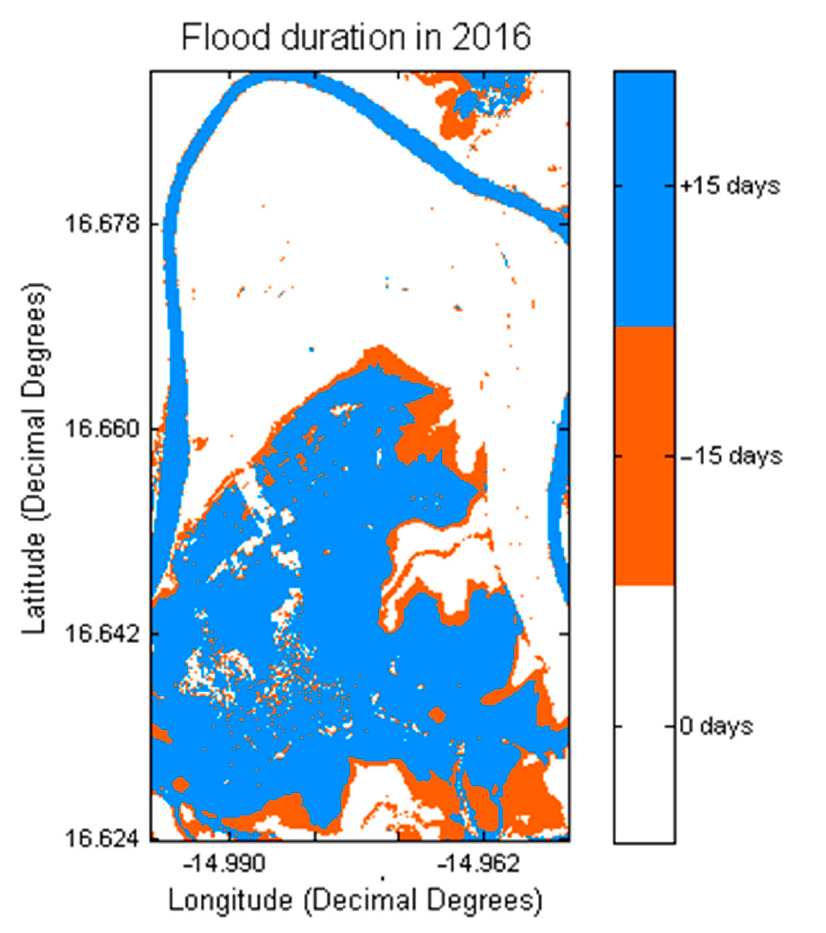
Figure 10. Surface areas flooded for less (and more) than 15 days in the Podor basin in 2016. Figure 11 shows the annual evolution of the flooded area S (ha) and that of the river level h (cm) and a similar evolution can be seen between the two curves. The lack of images at certain periods or the existence of clouds did not allow a higher accuracy on the maximum surface reached. In order to take into account the portions of the watercourse present in the image, an estimated constant value of 150 ha was subtracted from the calculated area to obtain the flooded area The duration of submersion depends on the spread of the flood (duration of the maintenance of the high river level). For a given surface, the minimum duration of submersion can be estimated by joining horizontally the rising and falling parts of the flooded surface curve. Looking for a relationship between the river level and the flooded area, the best correlation (R 2 = 0.92) was obtained between the river level at day 1 and the flooded surface at day 5 (Figure